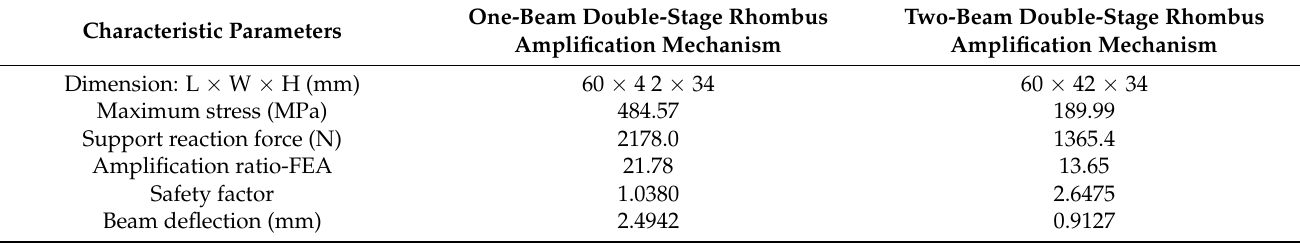
Figure 5. Stress and safety factor analysis of double-stage rhombus amplification mechanism with different number of beams. ( a ) One-beam; ( b ) Two-beam. Table 5. Partial characteristics and analysis results of the double-stage rhombus amplification mechanism with different numbers of